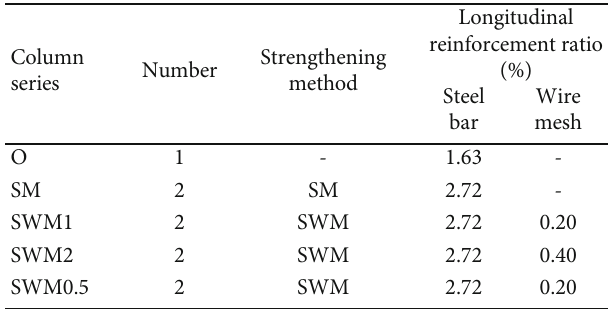
Table 2: Properties of